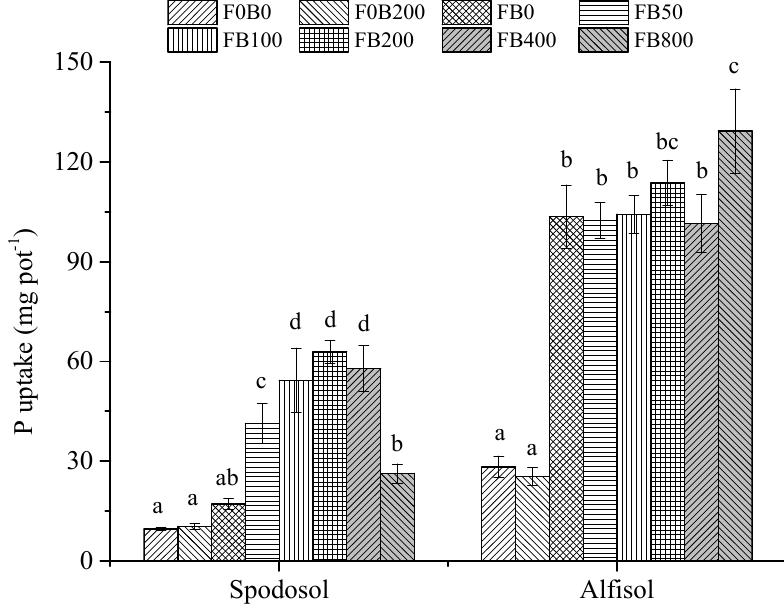
Figure 3. N uptake of maize plants affected by different application rates of CNPs in Spodosol and Alfisol soils. F0B0, control (without fertilizers and CNPs); F0B200, without fertilizers and with CNPs at 200 mg kg − 1 soil; and FB0, FB50, FB100, FB200, FB400 and FB800 represent those with fertilizers and CNPs at application rates of 0, 50, 100, 200, 400 and 800 mg kg − 1 soil, respectively. Error bars represent the standard error of the mean ( n = 5). The letters a, b, c, and d indicate statistically significant difference at p < 0.05 within each group comparison between the treatments. Bars with no common letters are significantly different ( p < 0.05).